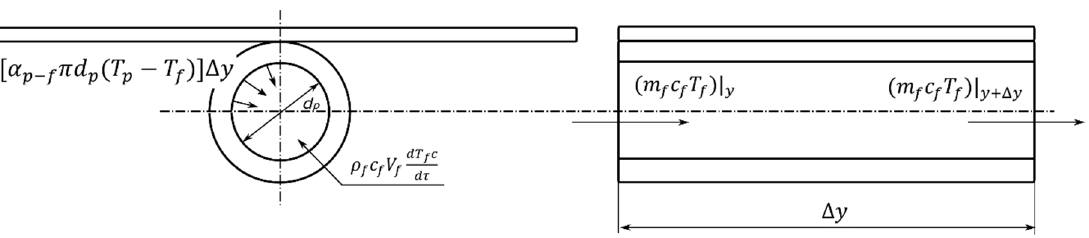
Figure 6. The energy balance of the flow pipes.